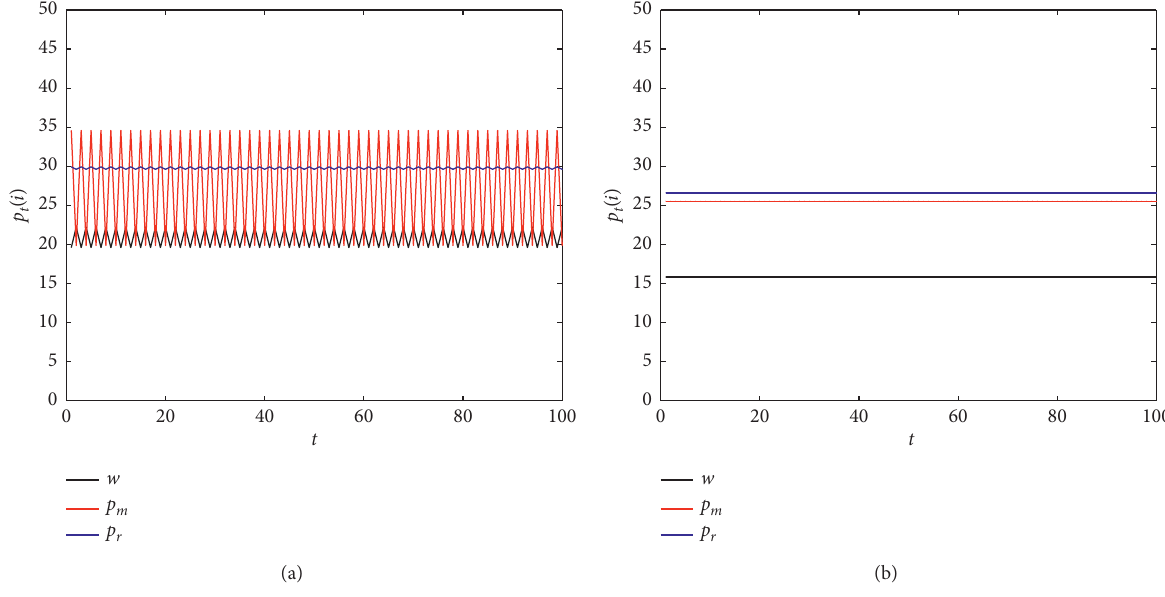
Figure 13: Price wave plot with the change of time when α